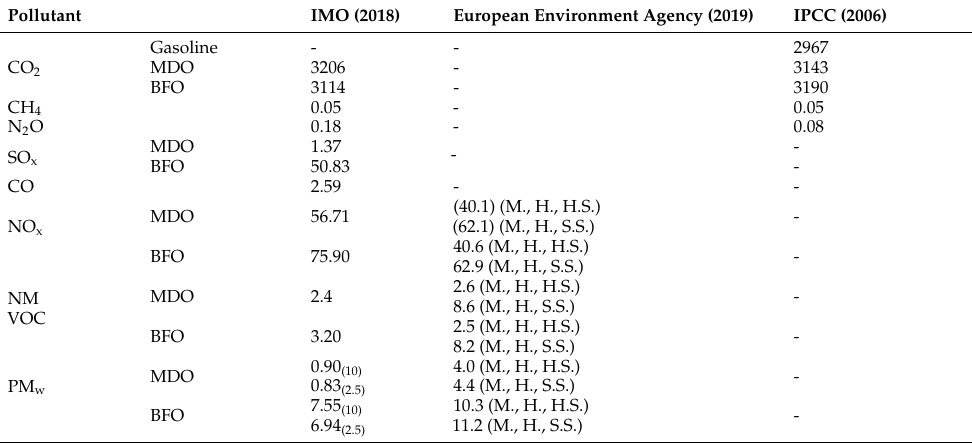
Table 5. Comparison of emission factors (Unit: